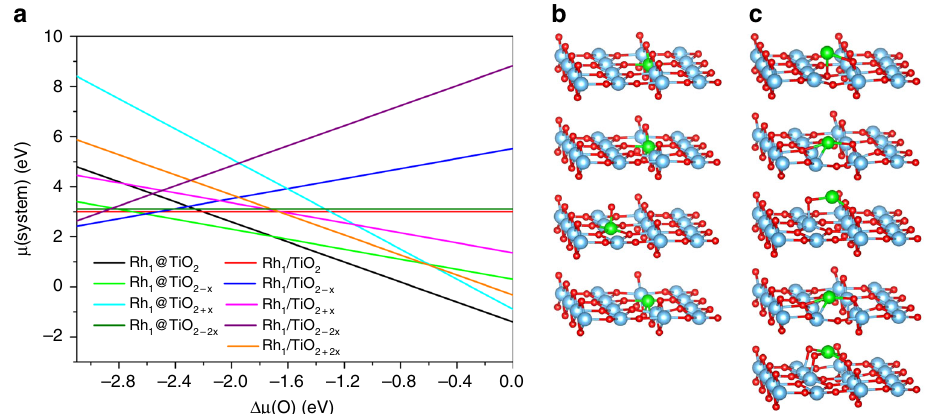
Fig. 1 Stability and structure of substitutional (@) and supported (/) single-atom Rh. The TiO 2 (110) surface is considered, including O vacancies or adatoms. a Relative stability as a function of oxygen chemical potential Δ μ (O). b , c The optimal structures for substitutional ( b ) and supported ( c ) Rh SAs on the considered TiO 2 surfaces. The structures in b , c follows the placement and order in the legend of a . Color code: O — red; Ti — blue; Rh —